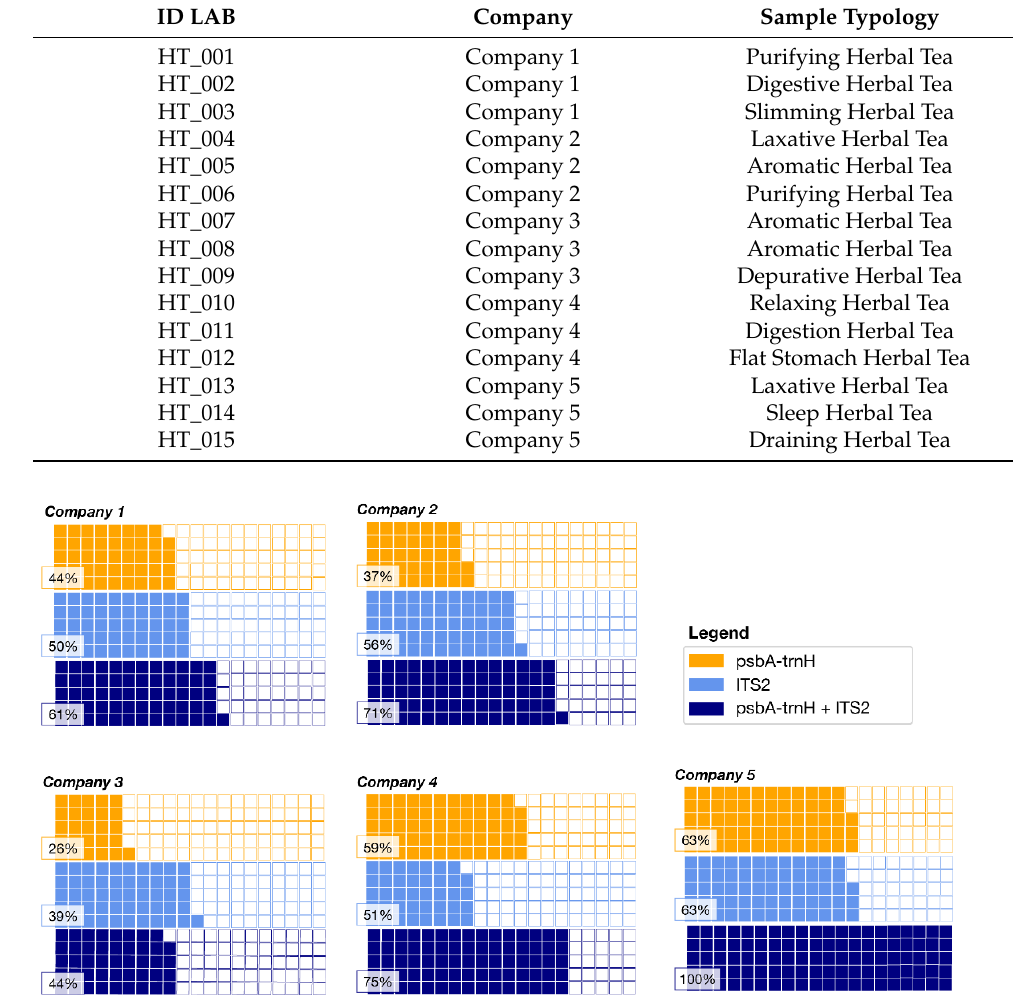
Figure 3. The waffle chart shows, in orange, the percentage of assigned taxa declared in the label for the barcode marker psbA-trnH , in light blue, the percentage of assigned taxa declared in the label for the barcode marker ITS2, and in blue, the total percentage using both markers for all the companies. The percentages of assigned taxa are reported in Supplementary Table